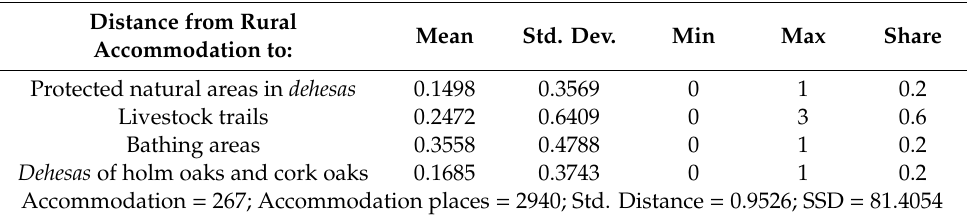
Table 11. Overall variable statistics.